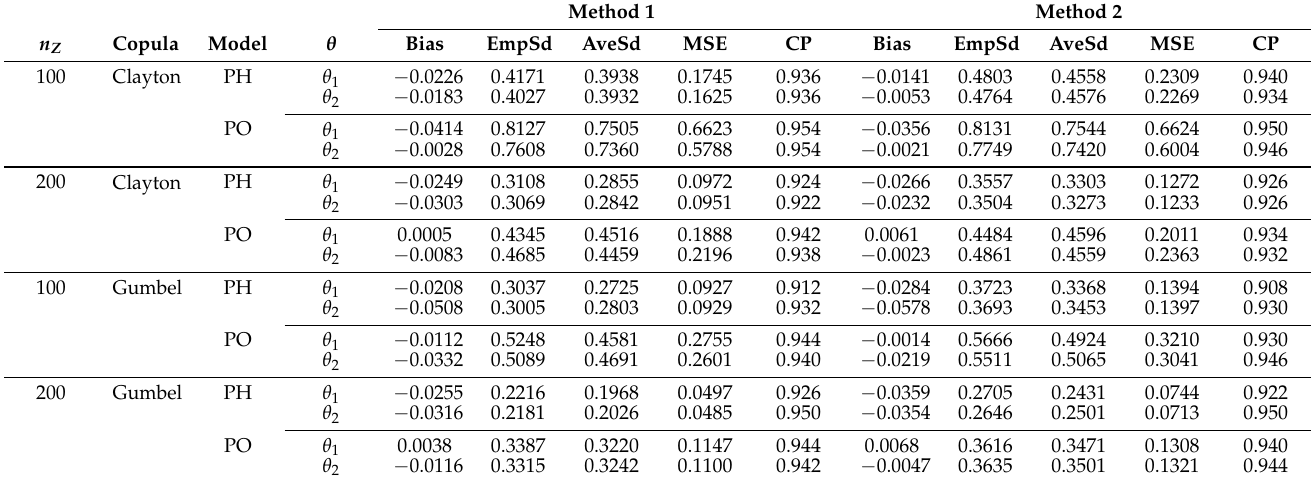
Table 3. The estimators of θ under Case 2 with τ = − 0.05 when the variable of interest is